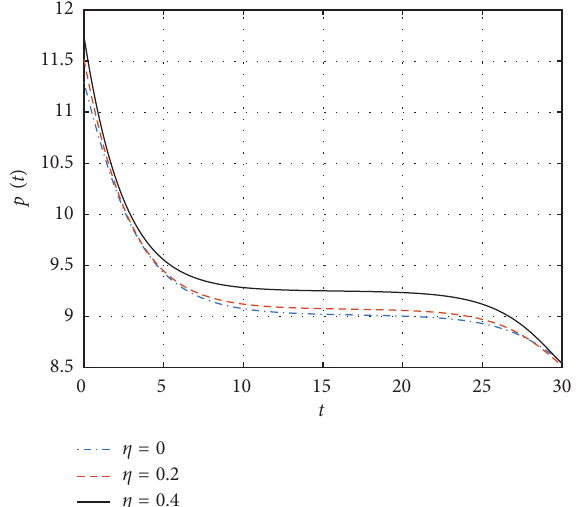
Figure 5: The optimal demand with different values of parameters η